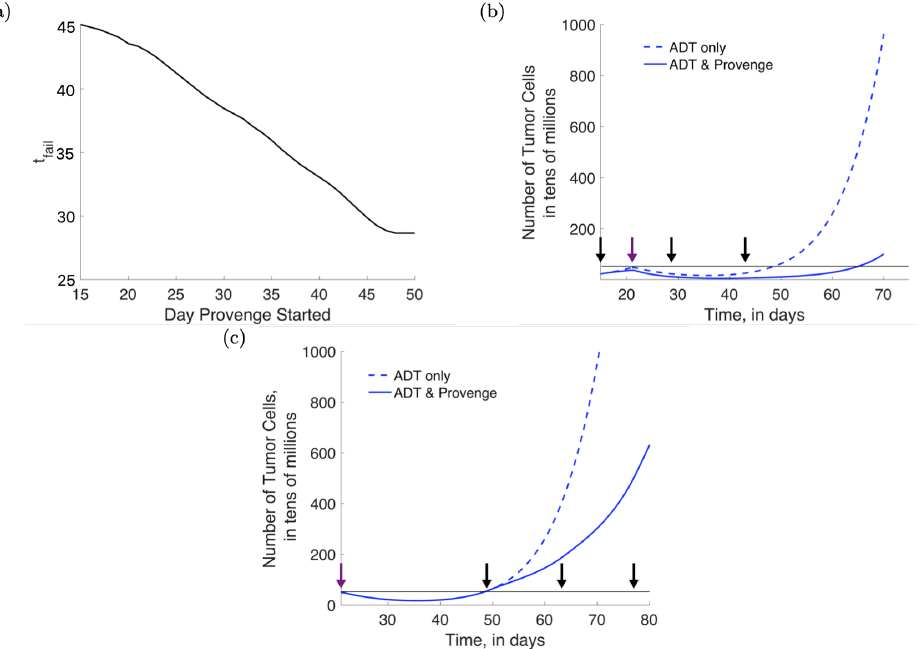
Figure 7. Optimizing ADT and Provenge scheduling when given in combination. ( a ) Predicted time to treatment failure as we vary the time of administration of the first dose of Provenge. In all cases, ADT was administered starting on day 21. ( b ) Predicted time courses of cell numbers after optimized administration of ADT and Provenge with ADT starting on day 21 and Provenge starting on day 15 (solid blue curve). ( c ) Predicted time courses of cell numbers after administration of ADT and Provenge per current clinical protocol with ADT starting on day 21 and Provenge starting on day 48, when ADT has failed (solid blue curve). In ( b , c ), the number of tumor cells with ADT alone is also plotted (dashed blue curve). The horizontal black lines corresponds to the treatment failure threshold (tumor volume of 420 mm 3 ). Here, the number of tumor cells refers to N + M + D A + D N